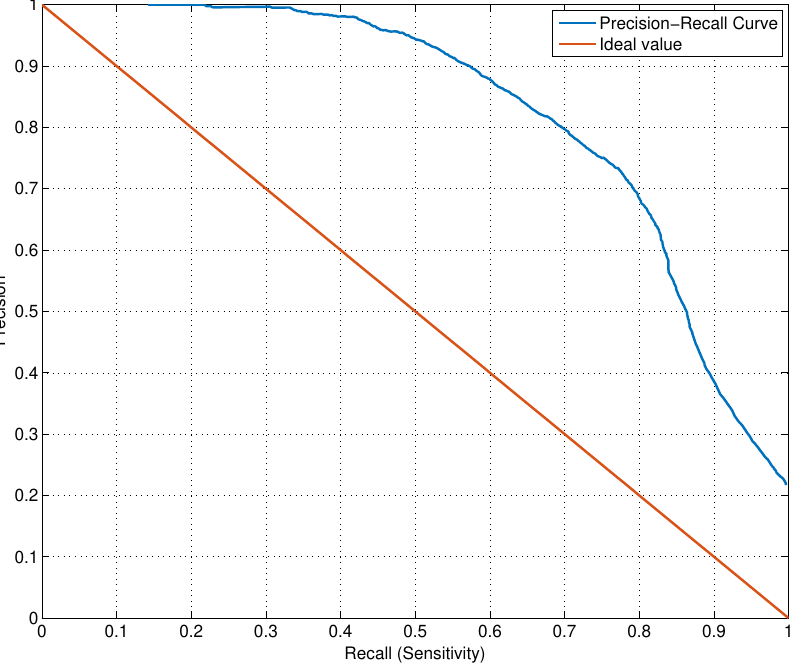
Figure 7. Precision–Recall (PR) curve of the proposed ANN